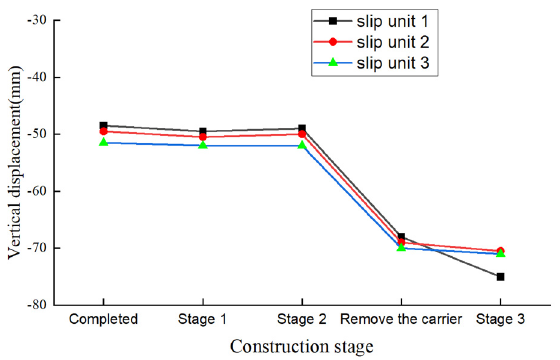
Figure 20. Vertical displacement of prestressed tensioning control